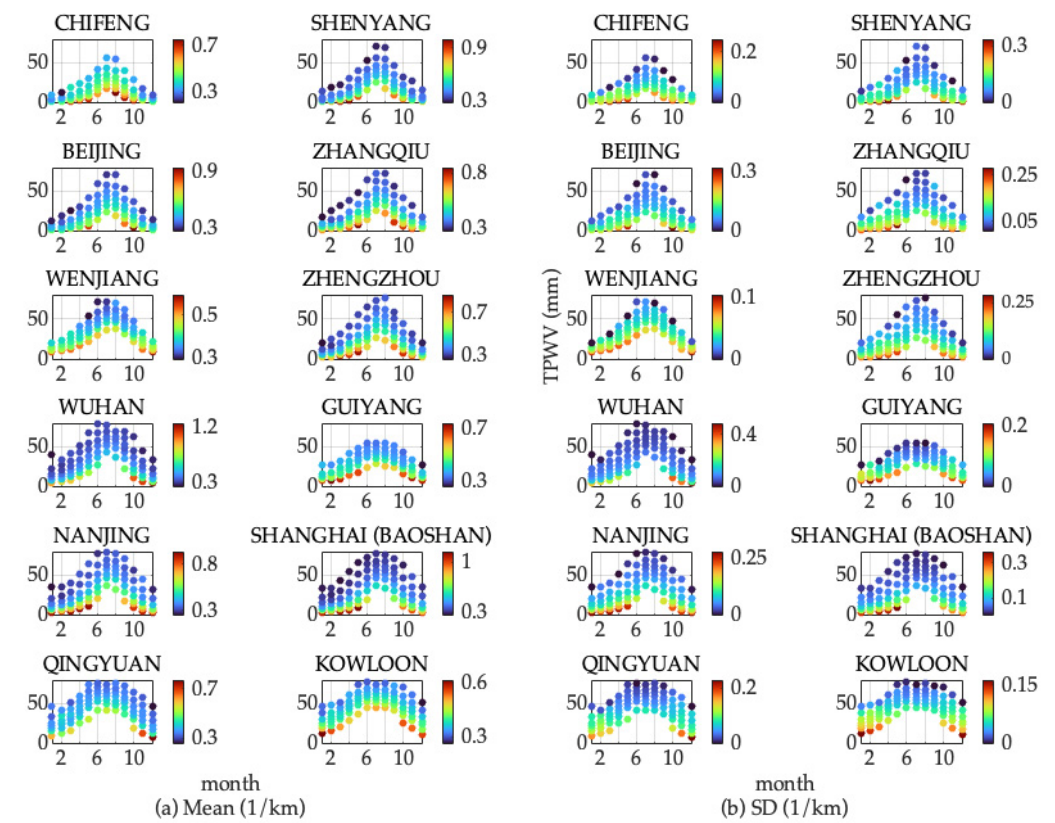
Figure 3. Monthly IRPWV mean ( a ) and SD ( b ) values (unit: 1/km) of each of the TPWV groups are sorted by their corresponding TPWV in the first layer at each of the 12 stations. The color bars of ( a , b ) indicate the values of the monthly mean and SD of IRPWV. The statistical results of other layers are shown in the Supplementary Materials.